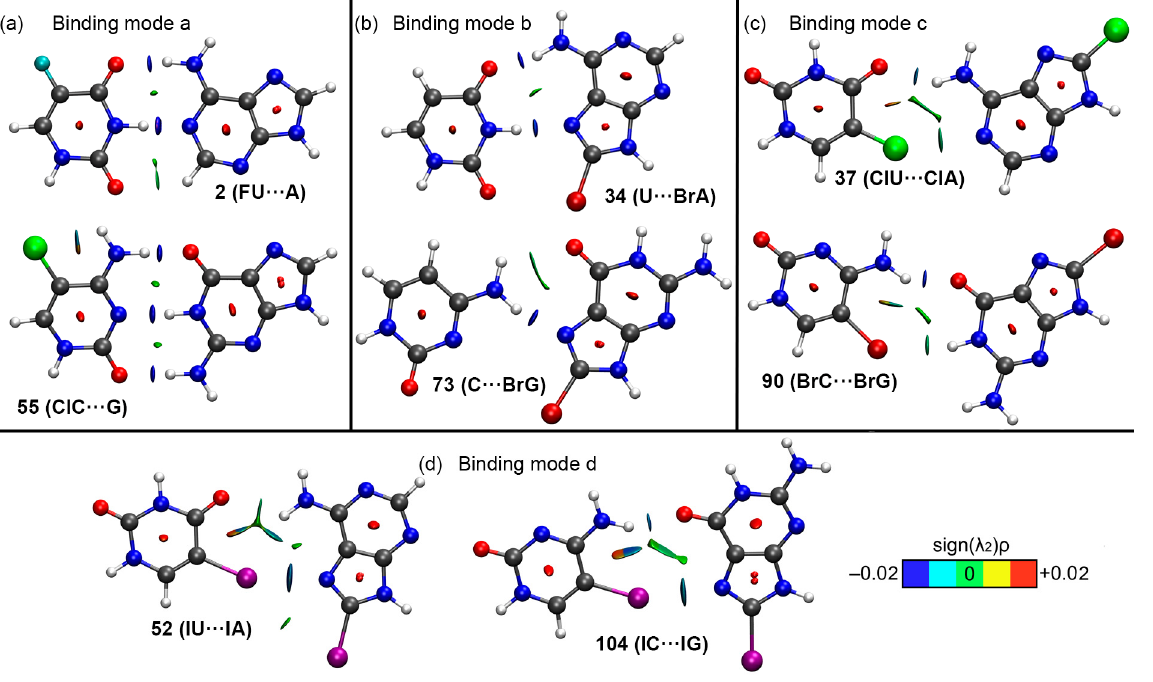
Figure 8. Intra– and Intermolecular NCIplot isosurfaces in several halogenated BPs. NCIplot colour range − 0.02 a.u. ≤ (sign λ 2 ) ρ ≤ − 0.02